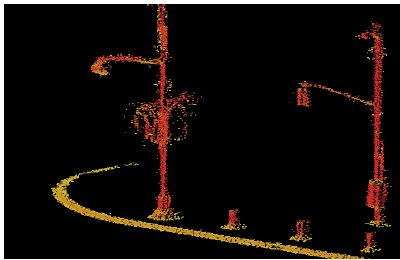
Figure 7. No ground points surrounding the poles’ bases.